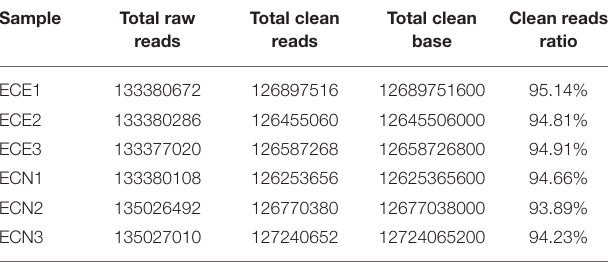
TABLE 3 | mRNA and lncRNA sequence counts between samples.